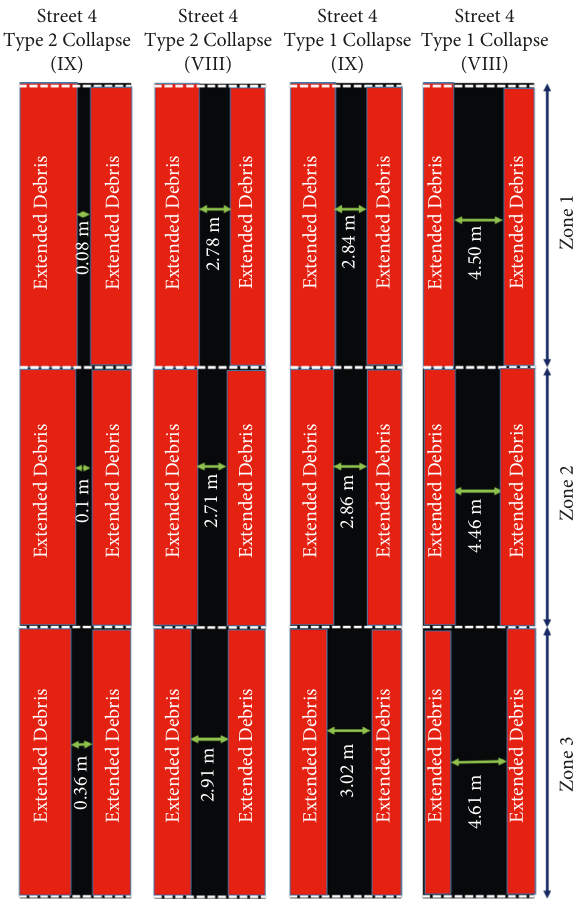
Figure 10: Representative figure for the obstructed zones of street number